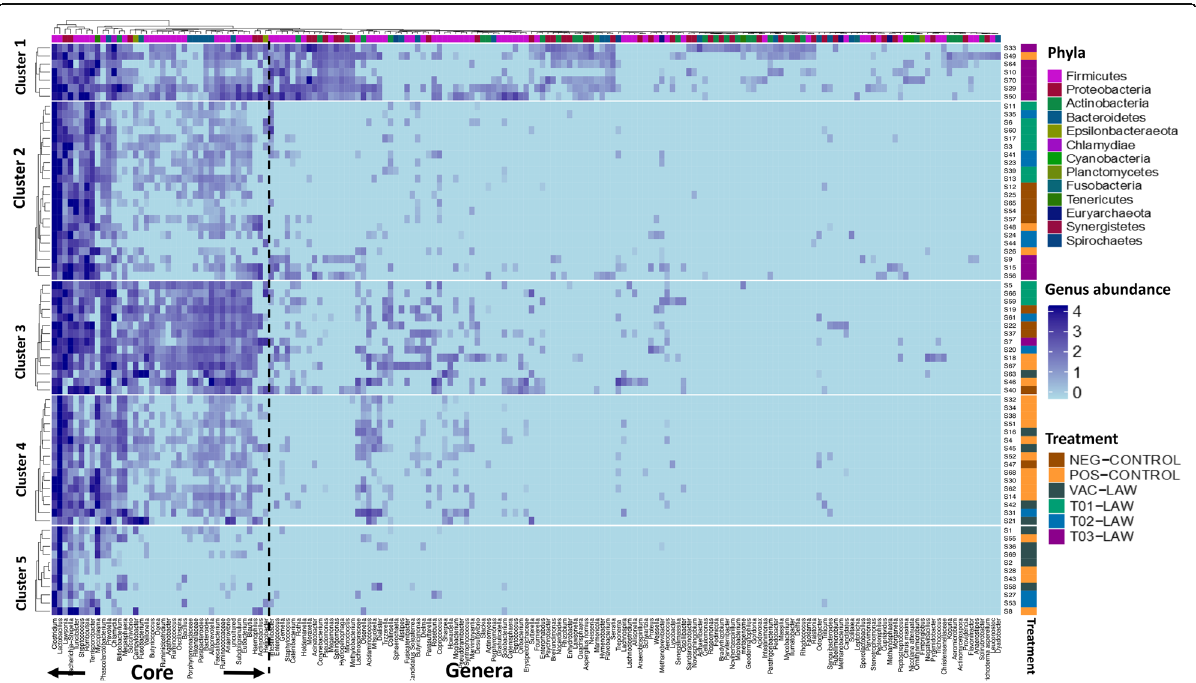
Fig. 3 The genus level microbial richness characterized in this study clustered by abundance levels. The clusters are linked to the treatment groups and sex. Note that the first 38 genera on the x-axis represent the core i.e. genera present in at least 85% of the